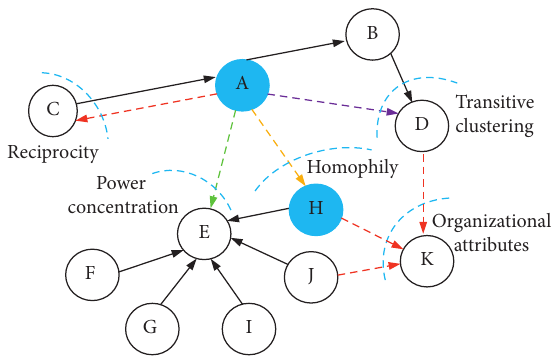
Figure 1: Strategies of partner selections. K represents public organizations or local organizations and blue represents organi- zations that have the same attribute (sector or